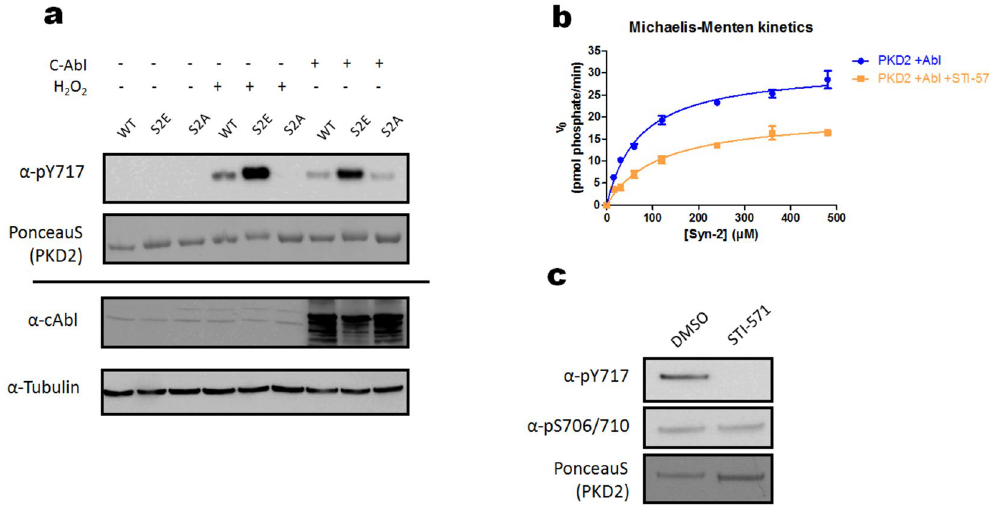
Figure 7. Tyr phosphorylation by Abl results in an increase in k cat independent of the activation loop Ser phosphorylation state. ( a ) Tyr-717 phosphorylation of a PKD2 S706/710A mutant can occur upon co- expression with Abl. HEK293 cells were transfected with FLAG-tagged wild type (WT) PKD2 or the indicated mutants alone or in combination with GST-tagged Abl. 48 h after transfection, cells were stimulated with H 2 O 2 (10 mM, 10 min) or left unstimulated and PKDs were precipitated from the cells using FLAG antibody. Immunoprecipitates were subjected to western blot and probed with the indicated antibodies. Western blots were cropped for clarity; uncropped images can be found in Supplementary Fig. S24. ( b ) Kinetics of PKD2 co-expressed with Abl with and without addition of STI-571 (5 µ M) before cell lysis. Protein concentration and purity (100%) was analyzed side by side by densitometry of a coomassie stained SDS-polyacrylamide gel using a BSA standard. Michaëlis-Menten kinetics for Syn-2 phosphorylation by each protein was followed in a radiometric kinase assay (see Materials and methods). ( c ) Analysis of Ser-706/710 and Tyr-717 phosphorylation of PKD2 purified from cells co-expressing Abl, with and without addition of STI-571. The purified enzymes described in 7b were analyzed for Ser and Tyr phosphorylation in the activation segment via Western Blotting with the indicated antibodies. Western blots were cropped for clarity; uncropped images can be found in Supplementary Fig. S25.